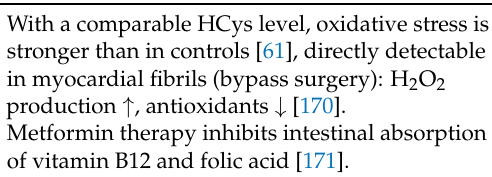
Table A2. Metabolic syndrome and type 2 diabetes